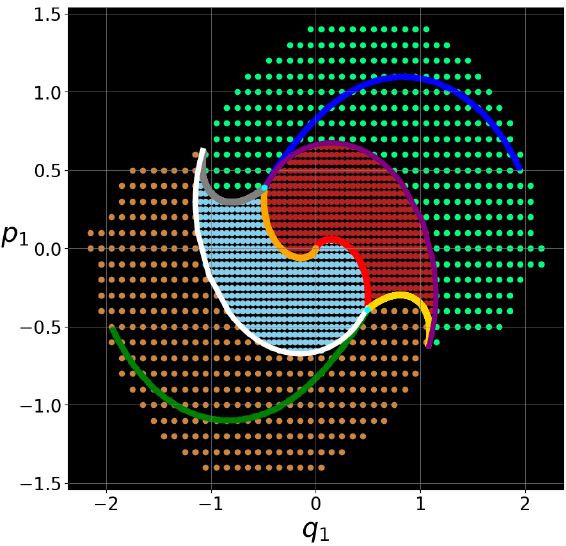
Figure 8. Terminal points of the phase plane of the first oscillator.